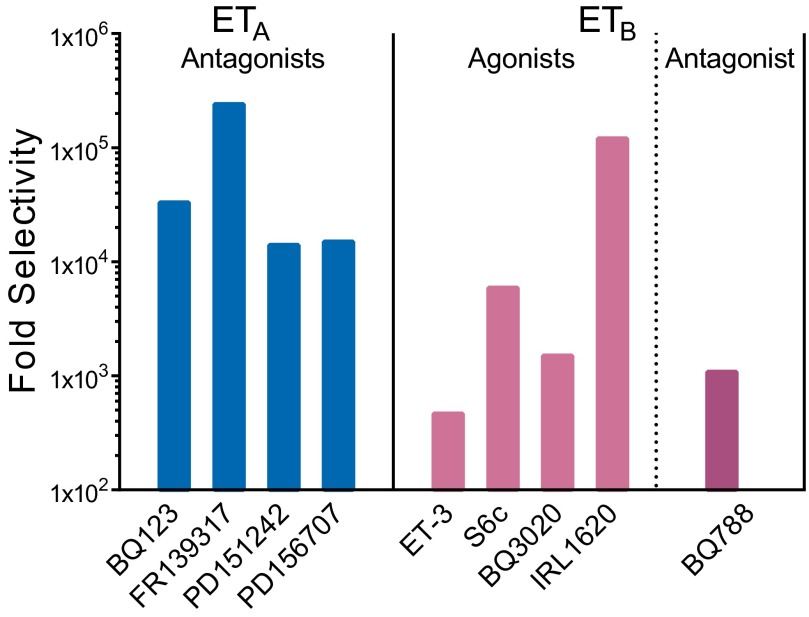
Comparison of the selectivity of ET ligands for native ETA and ETB receptors measured in the same competition binding assay against [125I]-ET-1. This assay uses human heart, which expresses both subtypes, resulting in a biphasic competition curve. Measurement of the affinity (the equilibrium dissociation constant or KD) of each compound at the two receptor sub-types can be accurately determined using non-linear iterative curve fitting. Comparison of the two affinities provides a measure of the selectivity for each subtype (Maguire and Davenport, 2012).